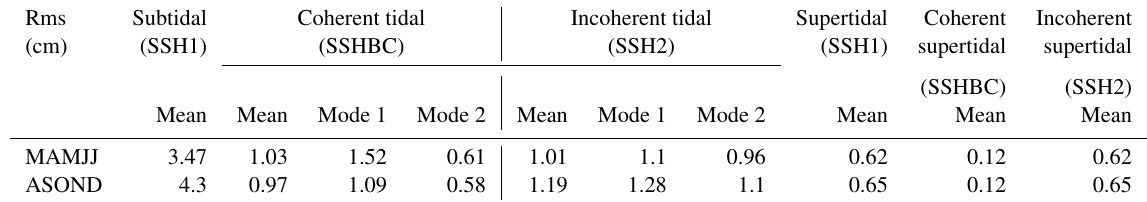
Table 2. Rms of SSH1 at subtidal frequencies; coherent (SSHBC) and incoherent (SSH2) at tidal frequencies; and SSH1, SSHBC, and SSH2 at super tidal frequencies. Mean refers to the mean of rms in Figs. 10 and 11 over the model domain. Mode 1 and mode 2 refer to the rms deducted from the integration of spectra in Fig. 13 over the wavelength bands 150–100 and 100–70km,